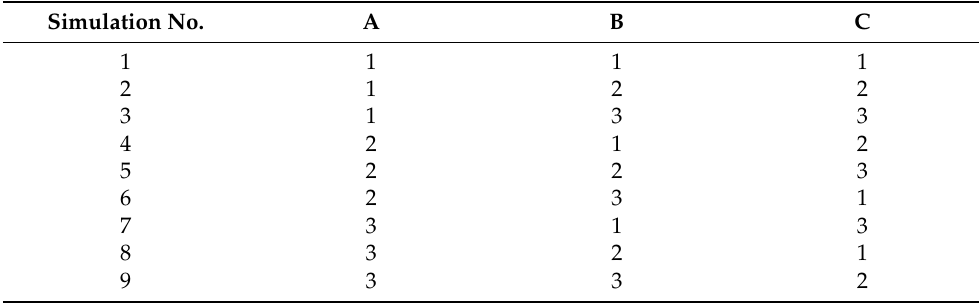
Table 10. L 9 (3 3 ) orthogonal